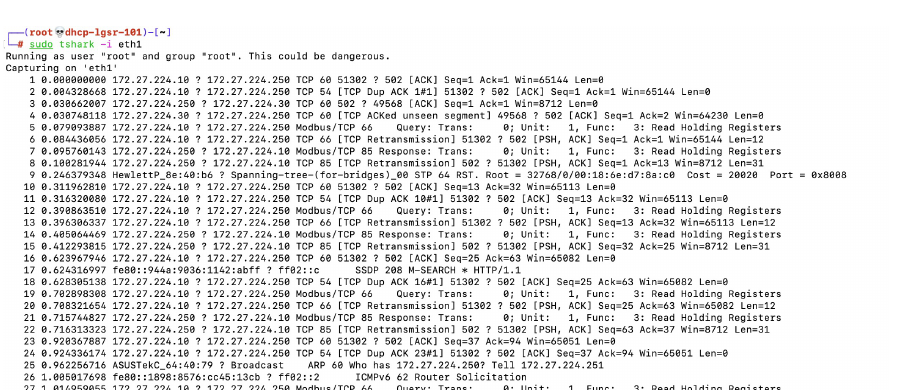
Figure 20. ARP poisoning-based MiTM attack.